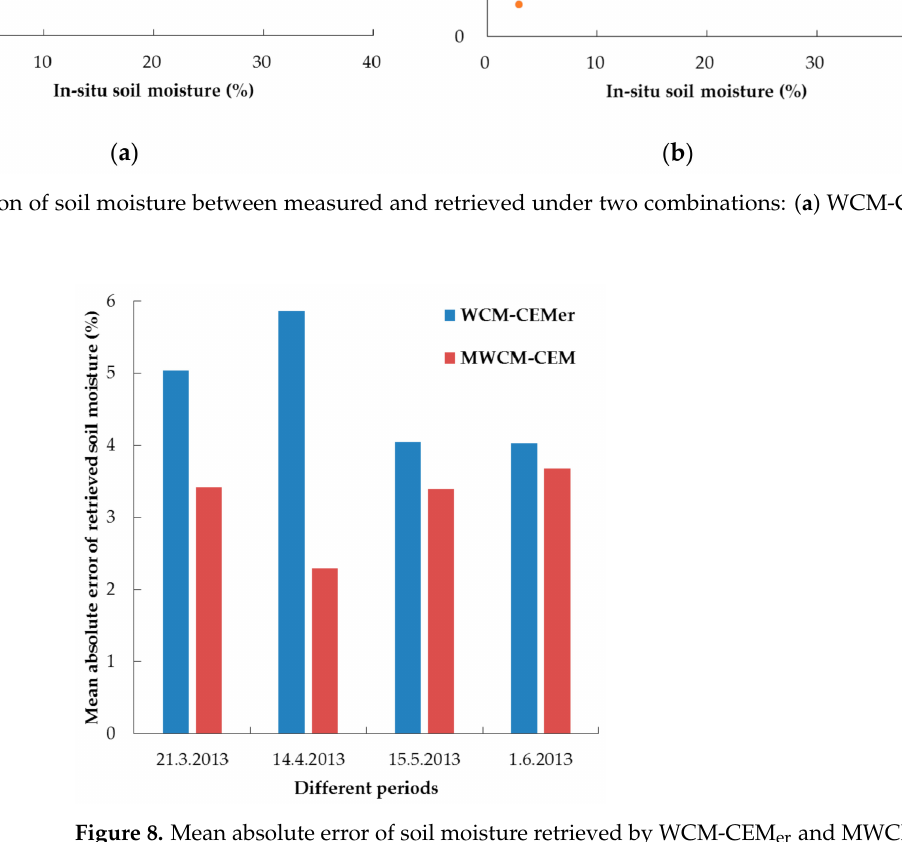
Figure 8. Mean absolute error of soil moisture retrieved by WCM-CEM er and MWCM-CEM in each